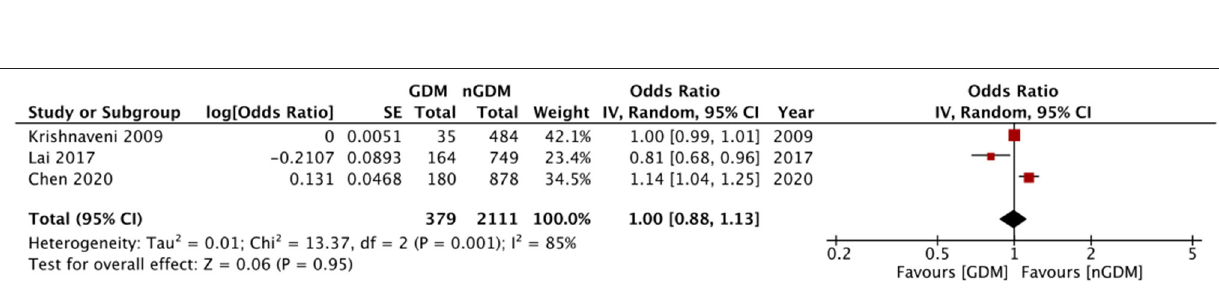
FIGURE 5 | Meta-analysis of adjusted odds ratios assessing relationship between GDM and serum folate (as continuous variable).